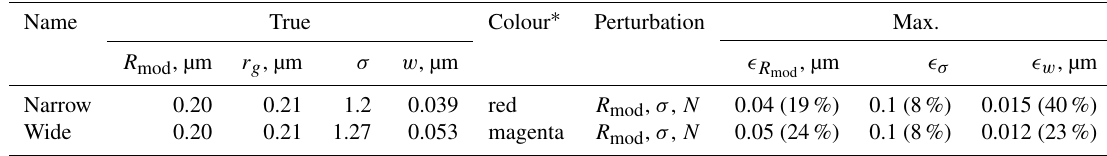
Table 2. Selected scenarios and associated maximum of absolute (relative) errors.